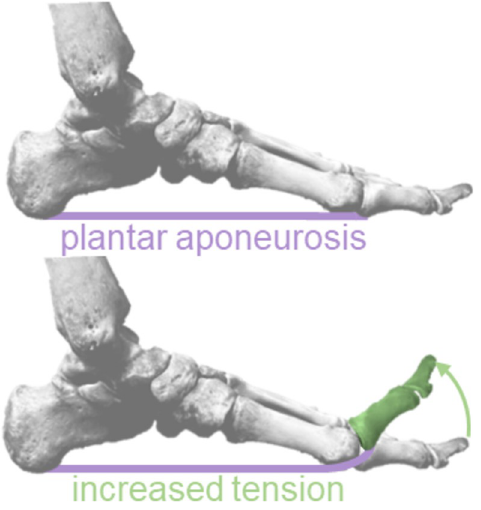
Fig 1. Metatarsophalangeal joint dorsiflexion increases plantar aponeurosis tension. The windlass mechanism, wherein dorsiflexion of the metatarsophalangeal joint increases the tension in the plantar aponeurosis, potentially increasing the rigidity of the foot’s